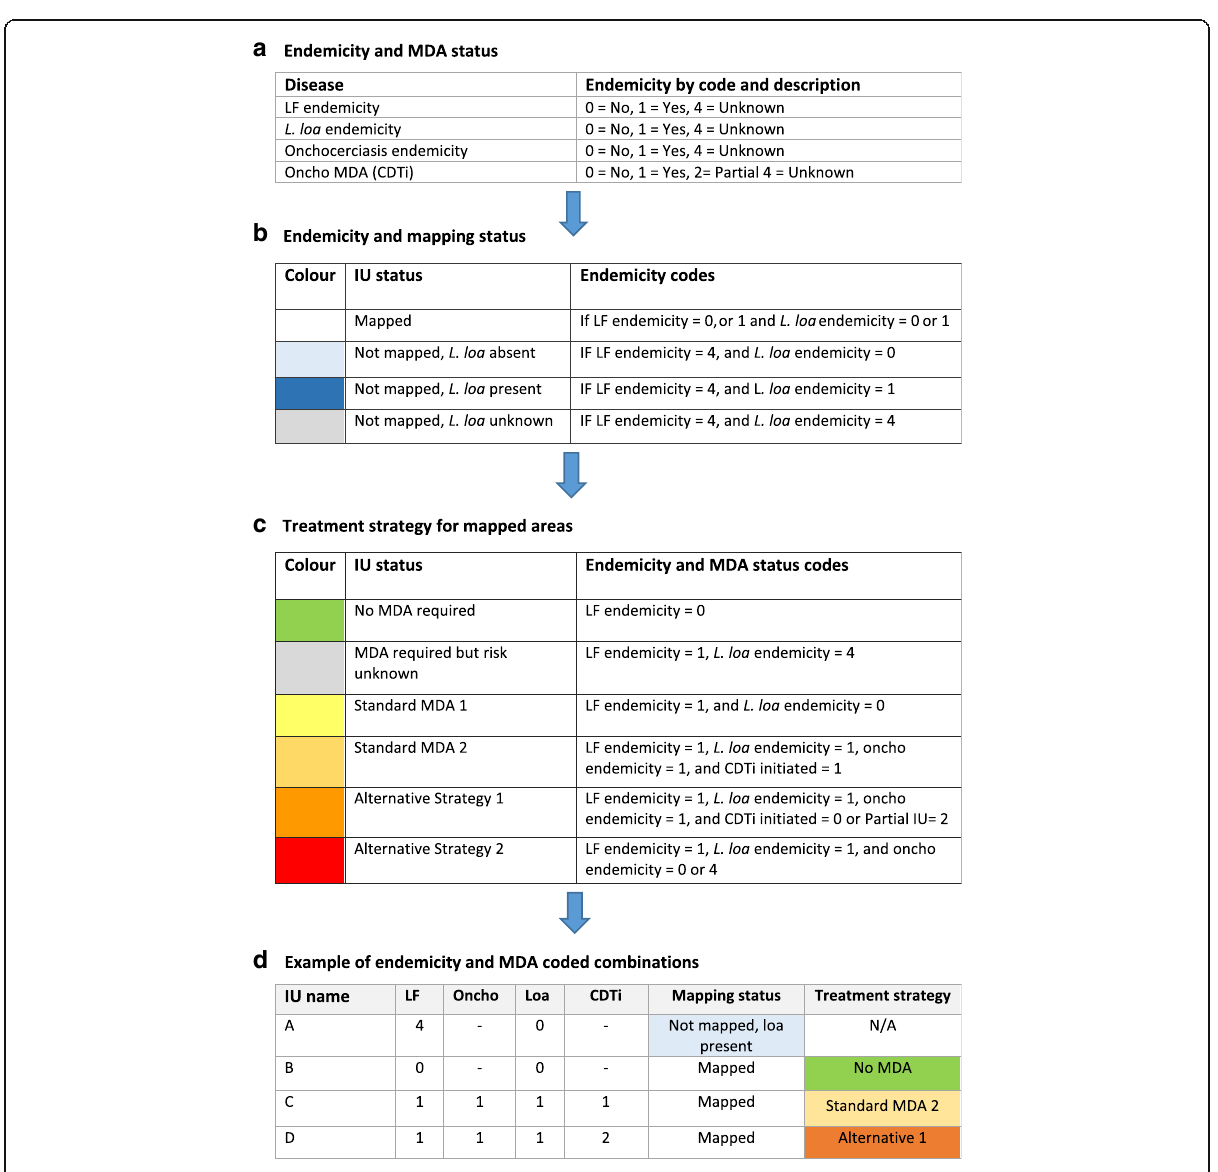
Fig. 1 Tabulated filarial endemicity, MDA status, mapping status and treatment strategies. (a) Endemicity and MDA status (b) Endemicity and mapping status (c) Treatment strategy for mapped areas (d) Example of endemicity and MDA coded